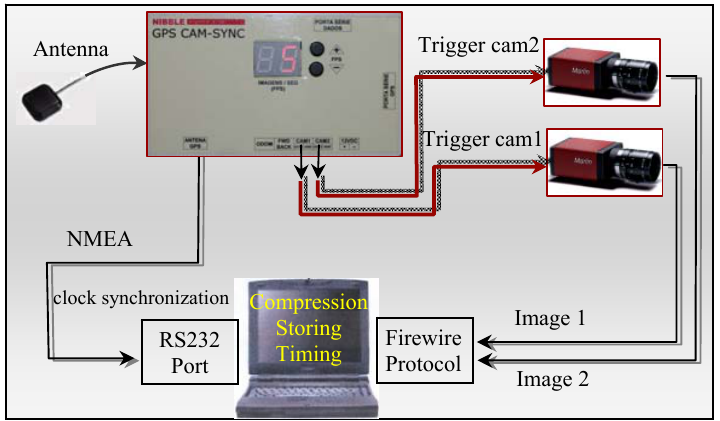
Figure 9. Image acquisition